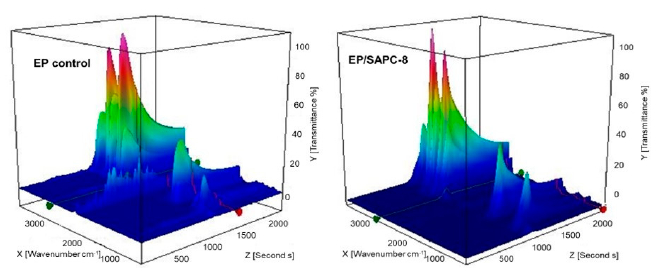
Figure 9. Three-dimensional (3D) TG-FTIR spectra of gasified pyrolysis products for the EP control and EP/SAPC-8.